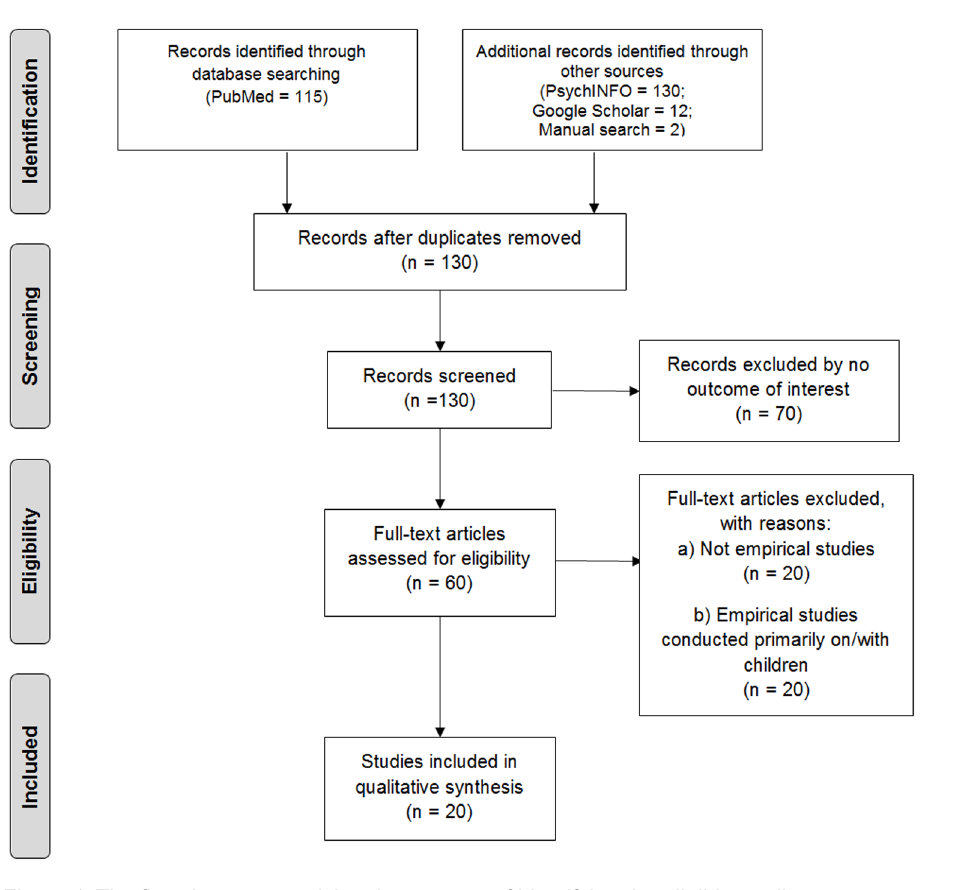
Figure 1. The flowchart summarizing the process of identifying the eligible